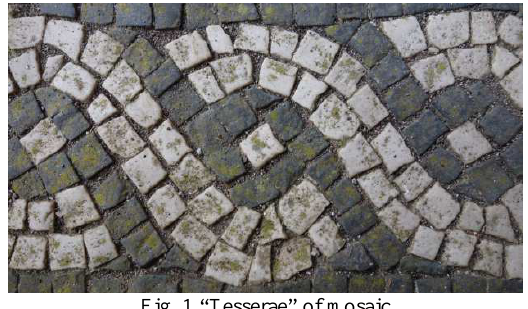
Fig. 1 “Tesserae” of